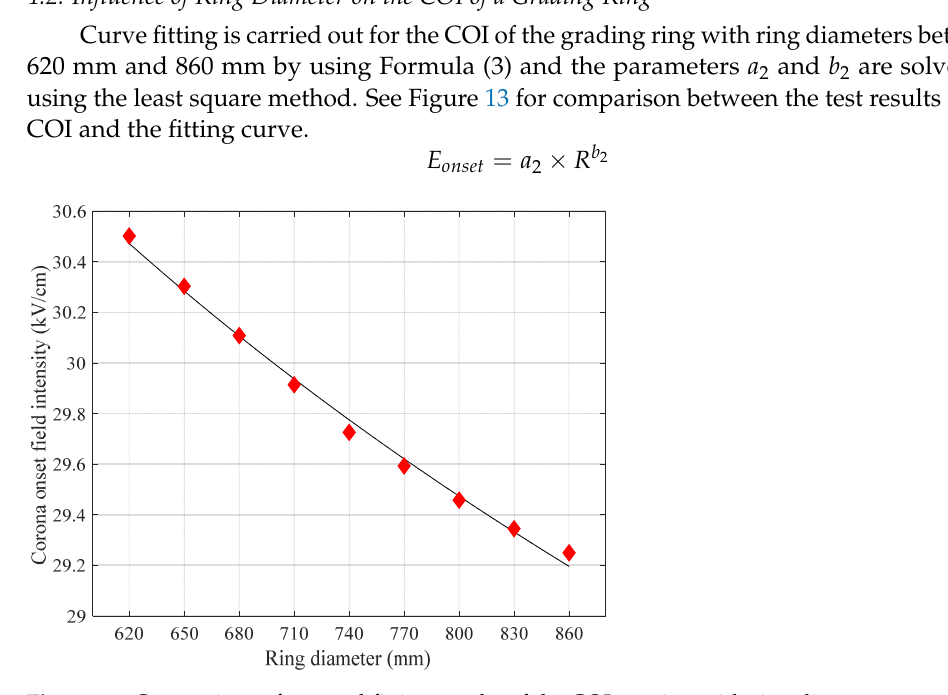
Figure 13. Comparison of test and fitting results of the COI varying with ring diameter.